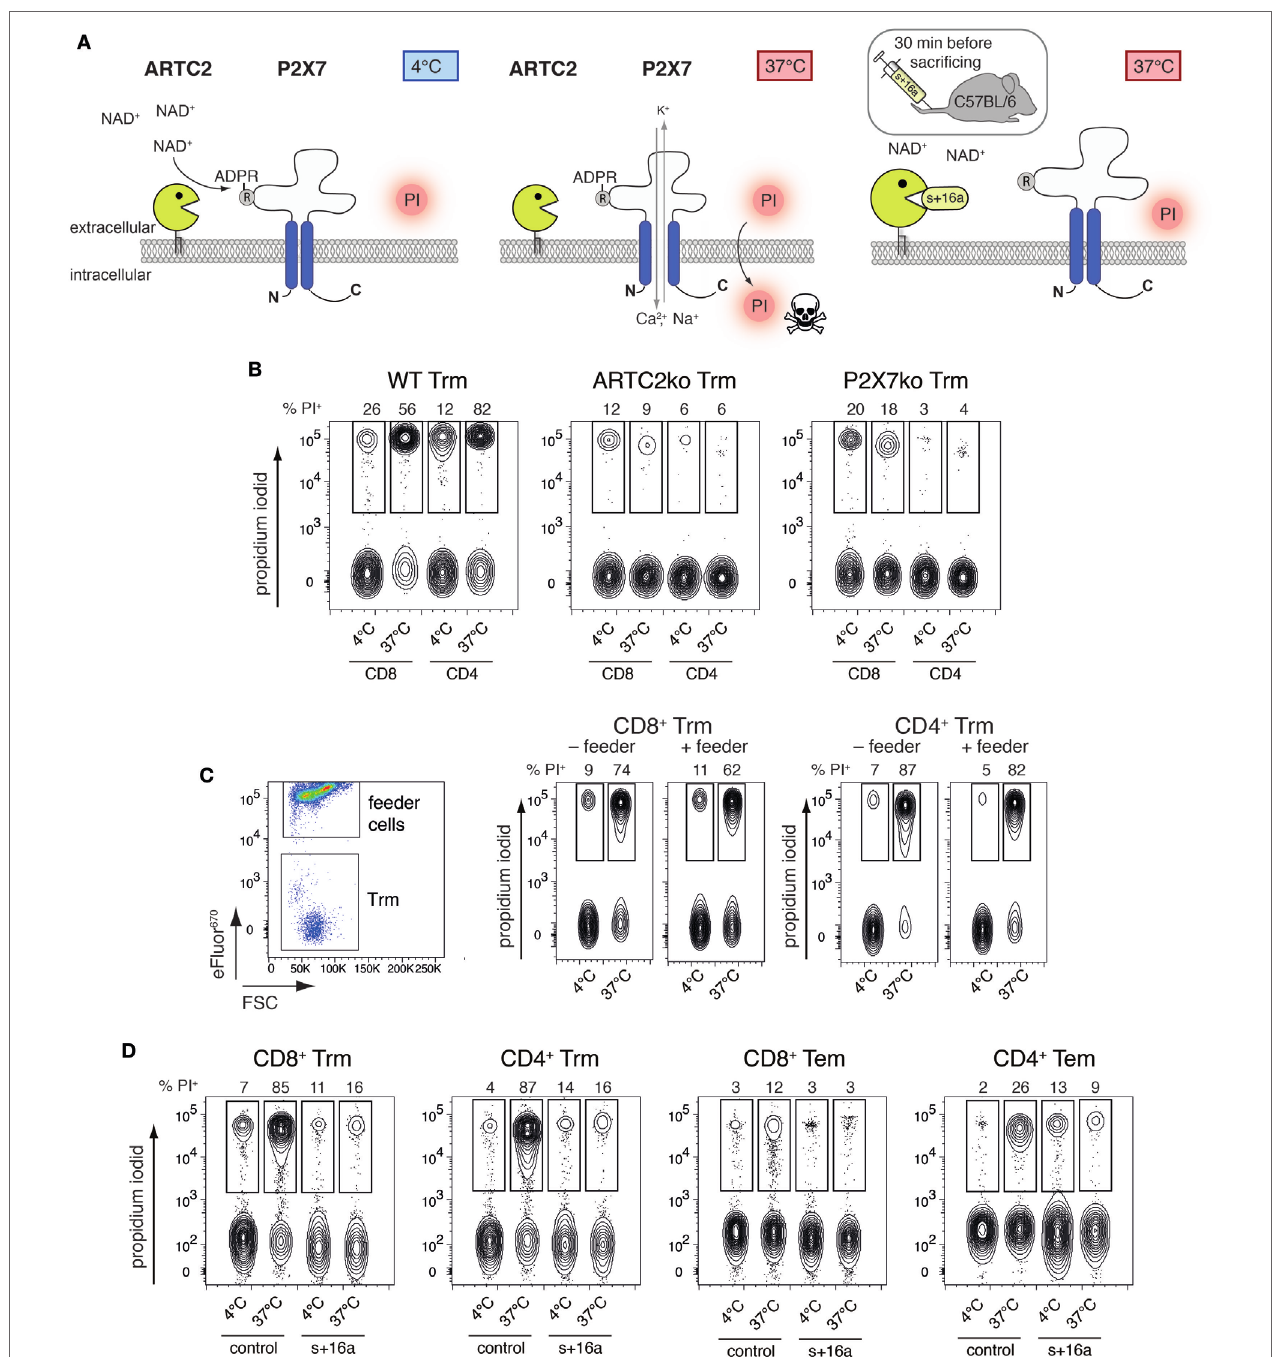
FIgURe 2 | ADP-ribosylation of Trm during cell preparation induces cell death upon 37°C incubation. (A) NAD + is released during cell preparation and serves as substrate for ARTC2.2 to ADP-ribosylate P2X7 at R125, even if cells are prepared at 4°C. ADP-ribosylation-mediated gating of P2X7 occurs when cells are brought back to 37°C, inducing Ca 2 + influx and ultimately cell death. ADP-ribosylation of P2X7 during cell preparation and subsequent activation of P2X7 at 37°C can be prevented by injection of the ARTC2.2-blocking nanobody s + 16a 30 min prior to sacrificing the mice. (B) CD8 + and CD4 + Trm were isolated via FACS from the liver of naïve WT, ARTC2ko, and P2X7ko mice. Cells were incubated at 37°C for 2 h and propidium iodide (PI) uptake was measured by flow cytometry as marker for cell death. (C) Isolated CD8 + and CD4 + Trm from the liver of naïve WT mice were cultured in the presence or absence of eFluor 670 -labeled feeder cells in a ration of 1:20. Cells were incubated at 37°C for 2 h and PI uptake by Trm was measured by flow cytometry as marker for cell death. (d) CD8 + and CD4 + Trm and effector memory T cells (Tem) were isolated via FACS from the liver of Lm infected mice 7 weeks after infection. One group of mice was treated with s + 16a prior to organ harvesting and the second group was left untreated as control. Cells were incubated at 37°C for 2 h and PI uptake was measured by flow cytometry as marker for cell death. The shown data represent results from two independently performed experiments.